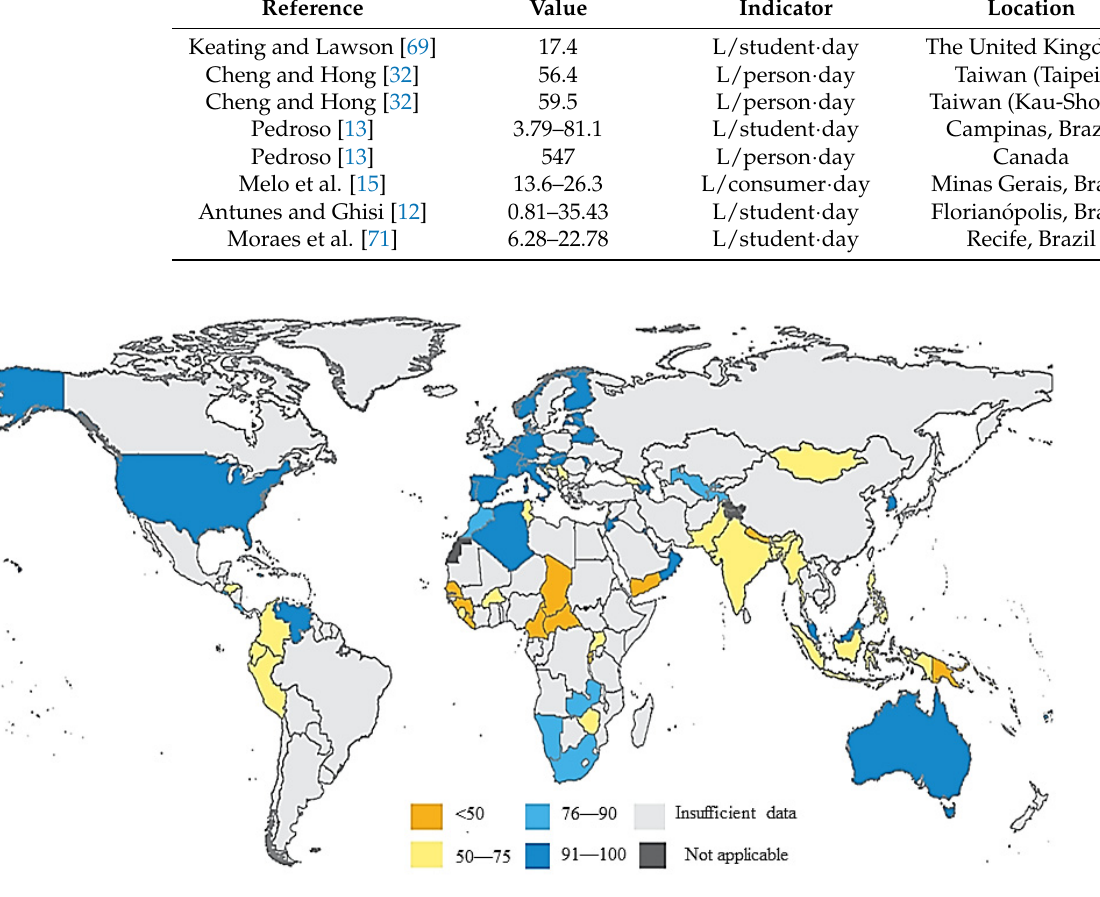
Figure 4. The lack of information on water use in schools